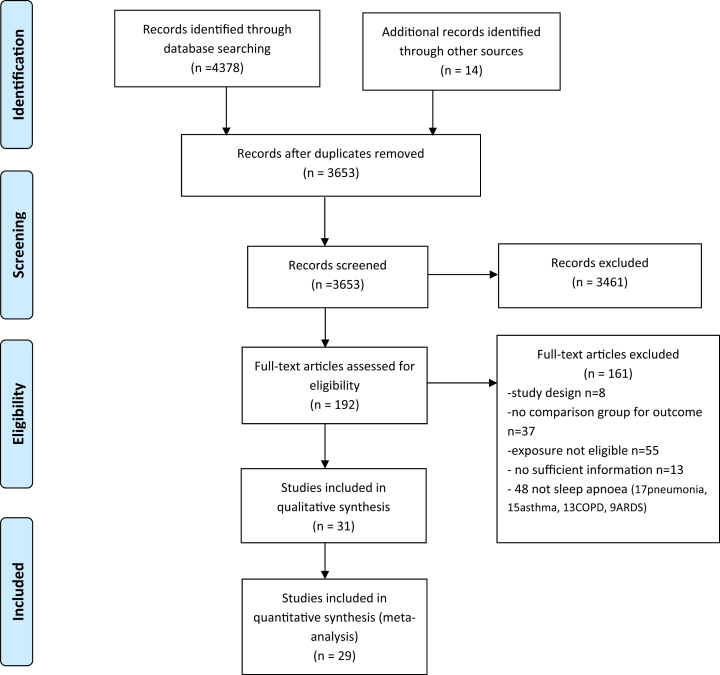
Flow chart of studies.